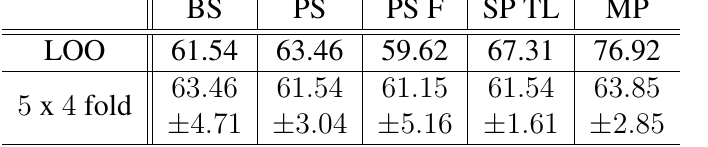
Table 3: Prediction Accuracies obtained by the different biclustering-based classifiers, using the 17 genes selected by Costa et al. [5]. Abbreviations as follows: BS - Biclusters Similarities, PS -